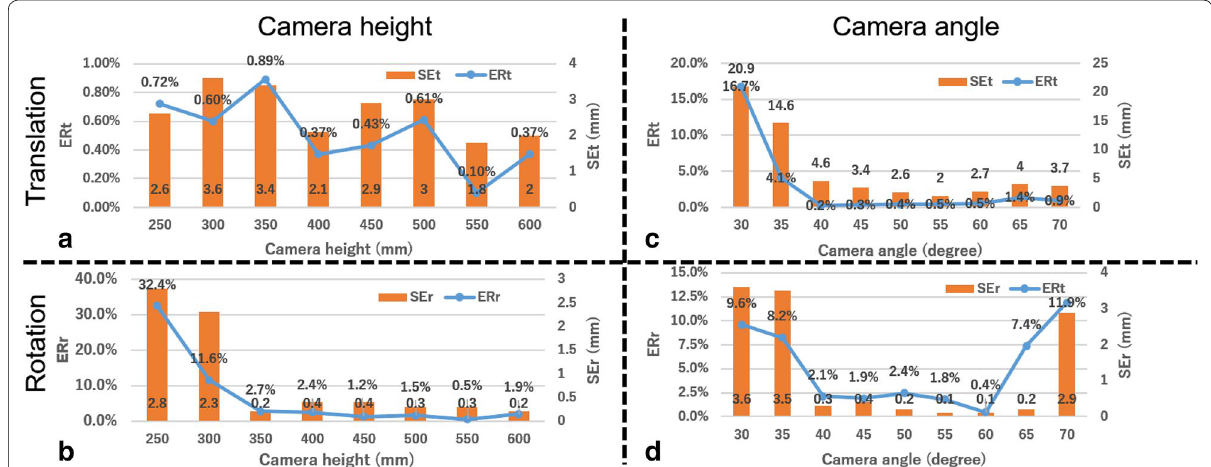
Fig. 13 Error rate and shift error with changing camera height and angle. a , c Translation motion; b , d rotation motion. a and b show the effect of the camera height, while c and d show the effect of the camera angle